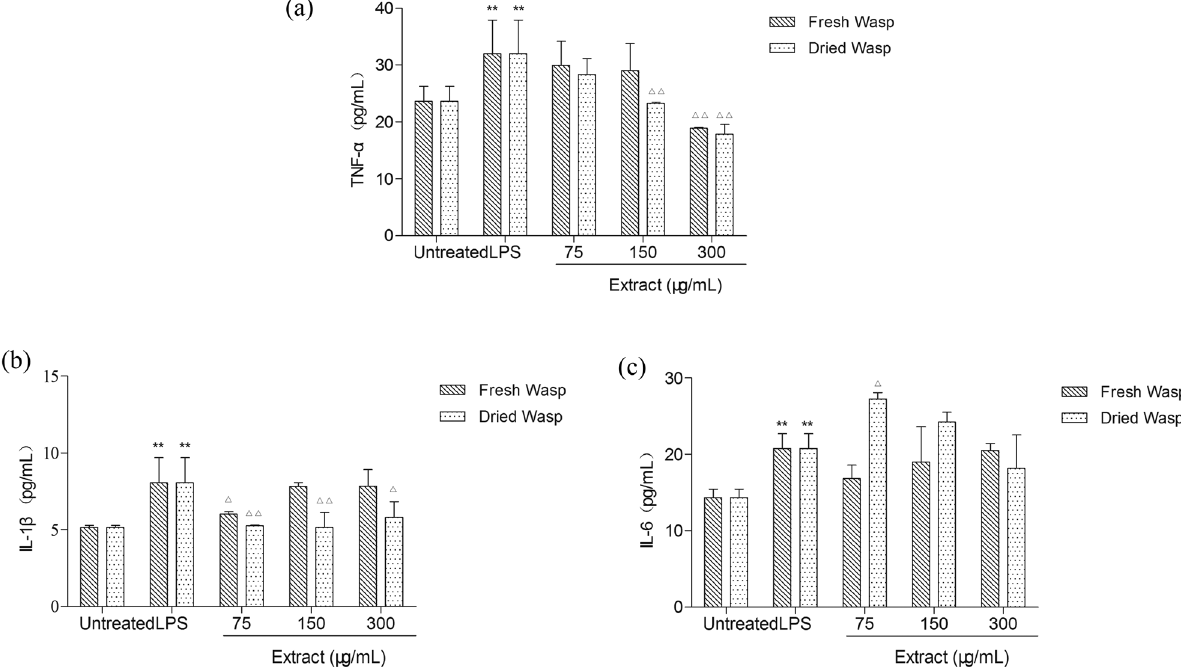
Figure 2: Inhibitory e ff ects of ethanol extracts on TNF - α ( a ) , IL - 1 β ( b ) , and IL - 6 ( c ) released in RAW 264.7 cells ( note: compared with the untreated group, * P < 0.05, ** P < 0.01; compared with the LPS group, Δ P < 0.05, ΔΔ P < 0.01 )